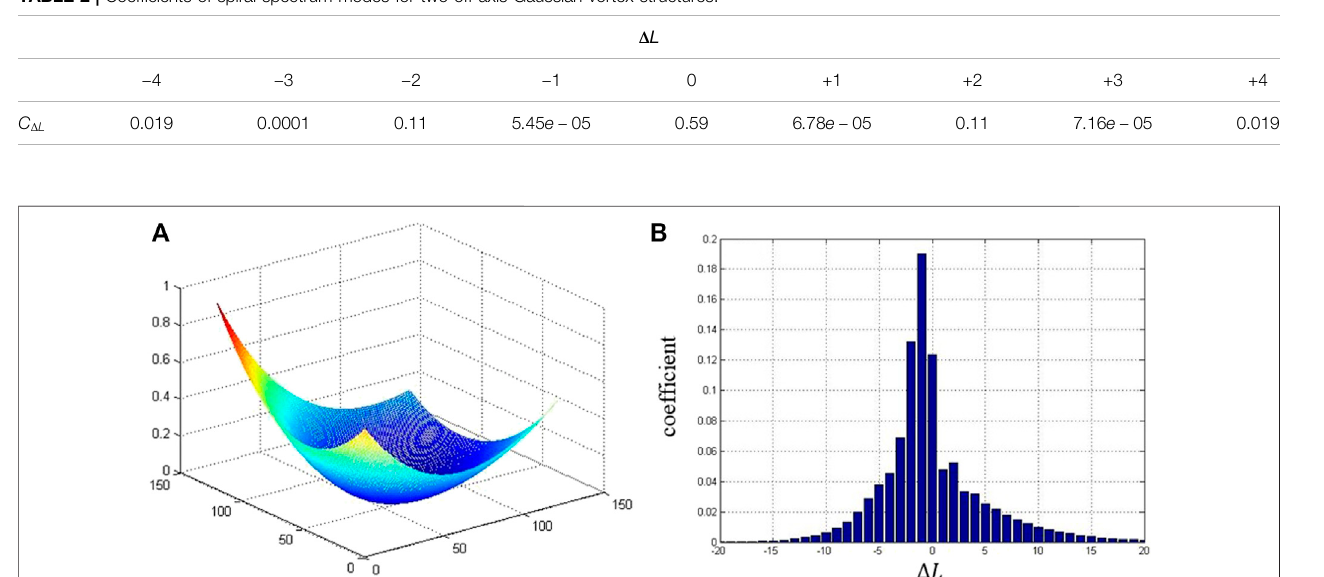
FIGURE 5 | The case of asymmetric spiral spectrum of light. (A) The phase distribution and (B) The spiral spectrum calculated by Eq. 3 .